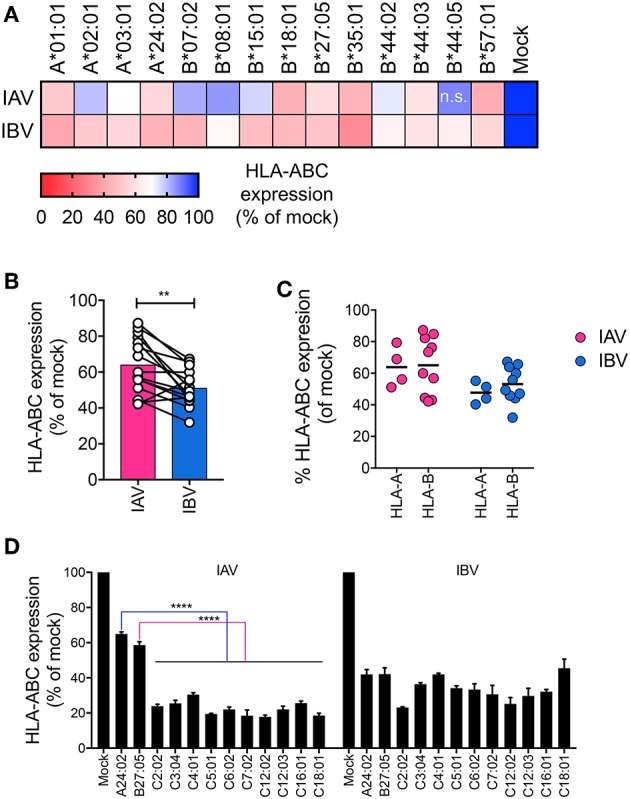
Downregulation of HLA-A, -B, and -C alleles by IAV and IBV. (A) Relative HLA-ABC expression on infected cells (NP+) compared to mock-treated cells, for IAV and IBV, across C1R lines expressing different HLA-A and -B alleles. Expression after infection for each allele is relative to that allele's respective mock-treated samples. Mean and SEM are shown for n = 6, pooled data from two independent experiments, each performed in triplicate. (B, C) Relative HLA-ABC expression on infected cells (NP+) compared to mock-treated cells, for IAV and IBV, where each data point represents the mean value (as above) for one allele. (D) Relative HLA-ABC expression on infected cells (NP+) compared to mock-treated cells, for IAV and IBV, across 721.221 lines expressing different HLA-C alleles. A24:02 and B*27:05-expressing lines were used for comparison. Expression after infection for each allele is relative to that alleles respective mock-treated samples. Mean and SEM are shown for n = 6, pooled data from two independent experiments, each performed in triplicate. Statistical significance was determined using unpaired Student's t-test throughout the figure with **p < 0.01, ****p < 0.0001.